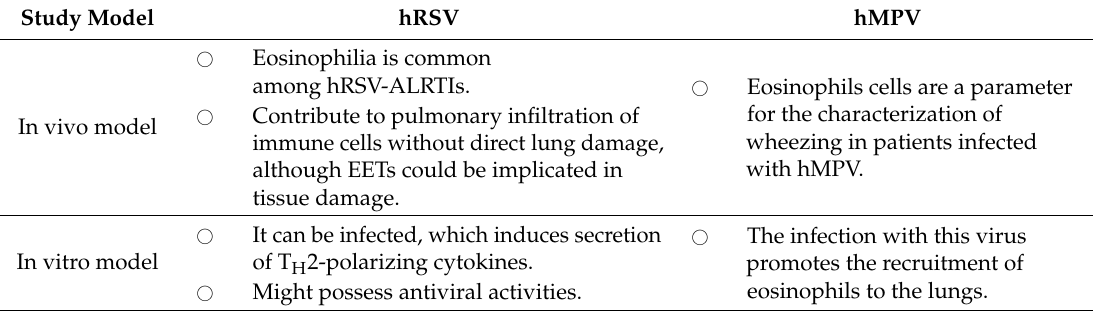
Table 4. Role of eosinophils in the pathology caused by hRSV and